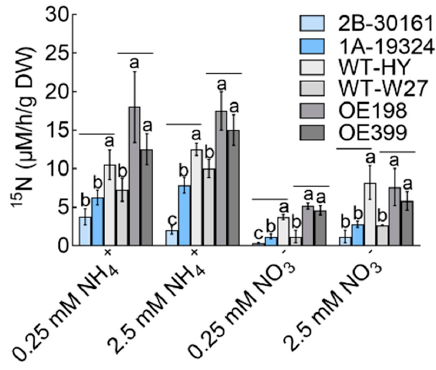
Figure 4. Effects of OsTBP2.1 overexpression lines and T-DNA insertion mutant lines on the root influx of 15 N for 5 min. OsTBP2.1 overexpression lines (OE) and T-DNA insertion mutant lines ( ostbp2.1 ) were grown in 1.25 mM NH 4 NO 3 for 3 weeks and nitrogen starved for 3 days. The 15 N influx rate was then measured at 0.25 mM 15 NH 4+ , 2.5 mM 15 NH 4+ , 0.25 mM 15 NO 3 − , and 2.5 mM − over a 5 min period. Error bars: SE (n = 5). The different letters indicate a significant 15 NO 3 difference between the transgenic line and the wild-type ( p <